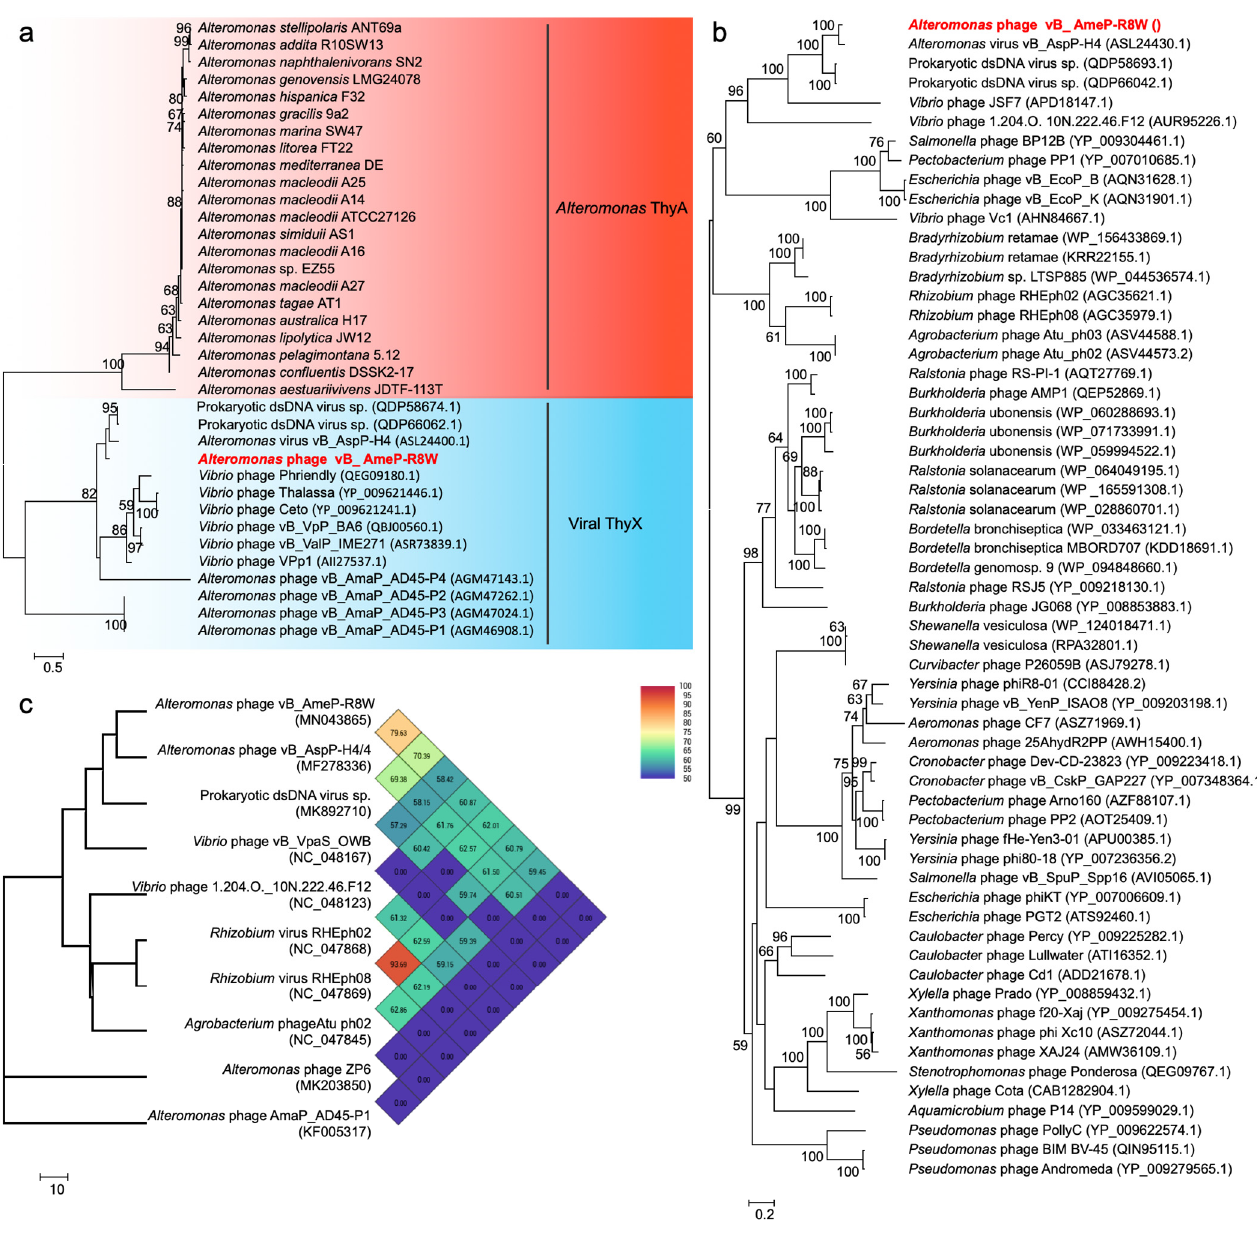
Figure 3. ( a ) Phylogenetic analysis of thymidylate synthase amino acid sequences of 22 Alteromonas and 14 phages. ( b ) Phyloge- netic analysis of TerL amino acid sequences of 60 phages. ( c ) The genome-wide tree based on the average nucleotide identity (ANI) from 10 phages. Numbers at the nodes indicate bootstrap values (1000 replications and values